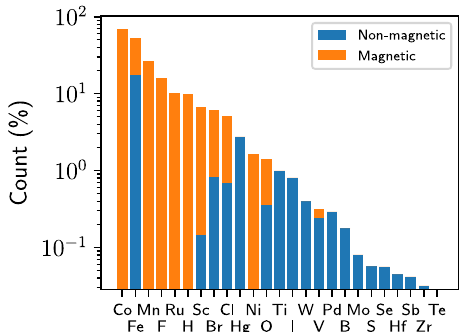
Fig. 3 QP-inconsistent solutions by element. Barplot showing the percentage of QP-ic Z values ( Z ∉ [0.5, 1.0]) for the given element. Non-magnetic materials are shown in blue and magnetic materials are shown in